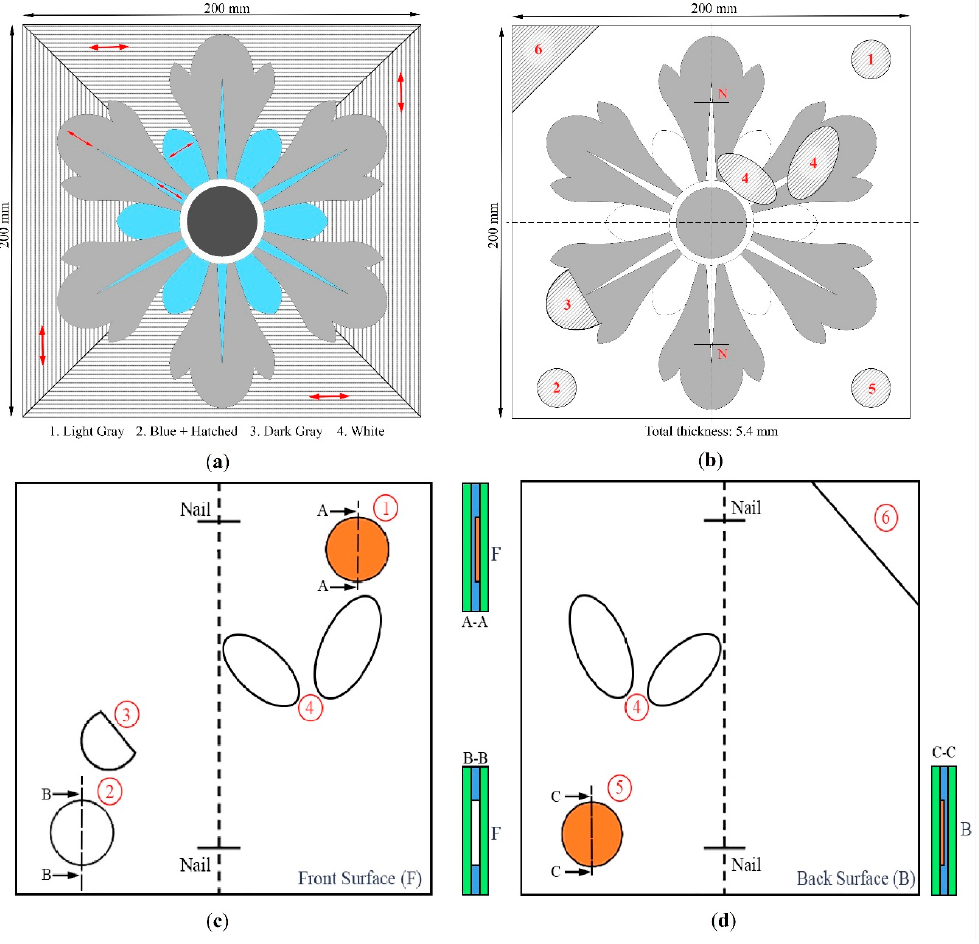
Figure2. Inlaysample: ( a )positionofthedefectsbeneaththefront(tessellatumlayer)side, ( b )additional Figure 2. Inlay sample: ( a ) position of the defects beneath the front (tessellatum layer) side, ( b ) explanationsofthepositionofsomedefects, ( c )positionofthedefectsbeneaththerearside, ( d )additional explanations of the position of the remaining